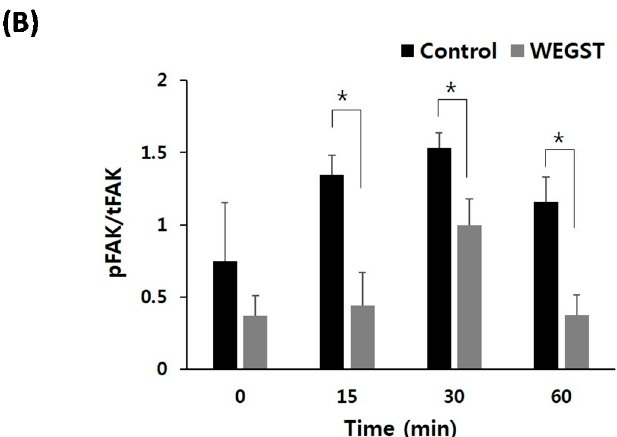
Figure 4. Collagen mediated activation of focal adhesion kinase (FAK) was impaired by WEGST treatments. The quiescent cells were pre-incubated with or without WEGST (50 µg/mL) and seeded in the collagen-coated plated, and then harvested at the indicated times. Cell lysates were western blotted with anti-phosphor FAK antibody, and the membrane was reproved and reacted with anti-FAK antibody for the detection of FAK expression. A representative figure of three independent experiments is shown ( A ); the activation ratio of phosphor FAK (p-FAK)/total FAK (t-FAK) is tabulated in the bottom panel ( B ). * p < 0.05, compared with control.